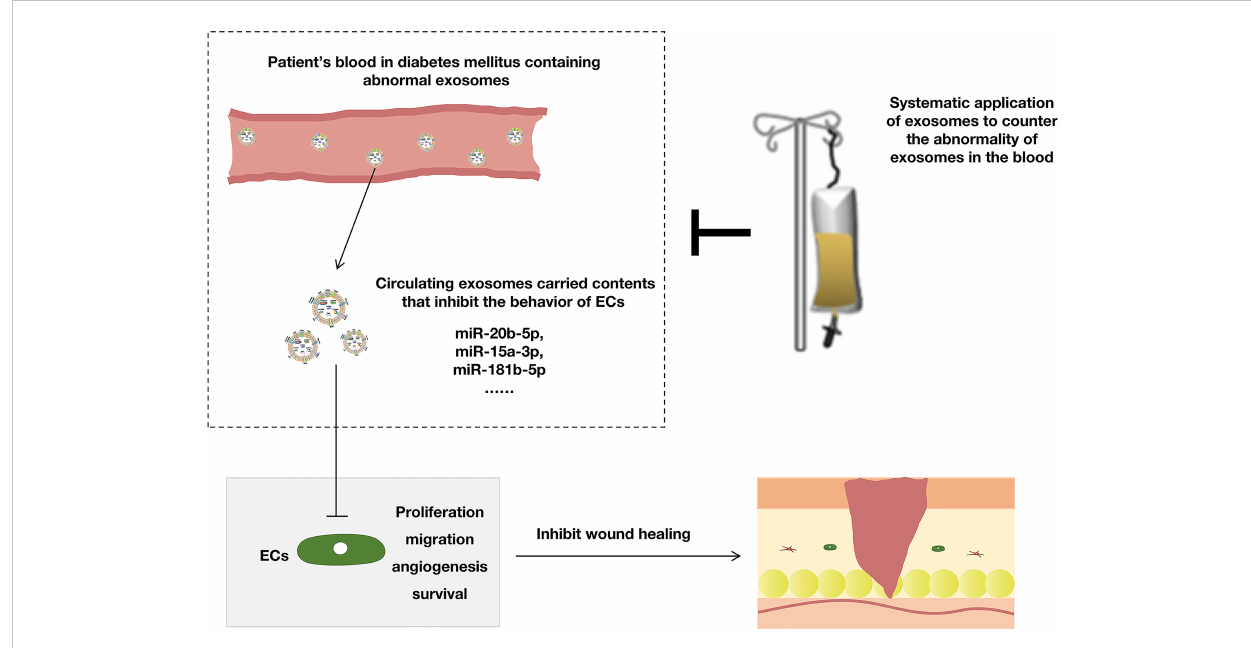
FIGURE 4 The systemic application of exosomes was bene fi cial to diabetic